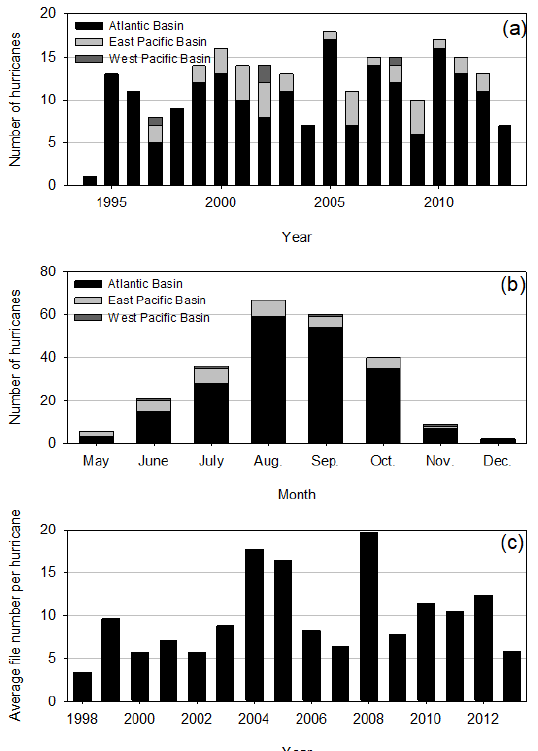
Figure 2. ( a ) Number of hurricanes in the HWind project during the period 1994–2013 depending on their basin. Most of them are located in the Atlantic basin. ( b ) Monthly distribution of hurricanes, where the highest frequencies ranged from August to October. ( c ) Average annual number of files per hurricane in the period 1998–2013. The years 2005, 2006, and 2008 stood out due to their noticeable values against 1998, which was the year with the lowest file number.